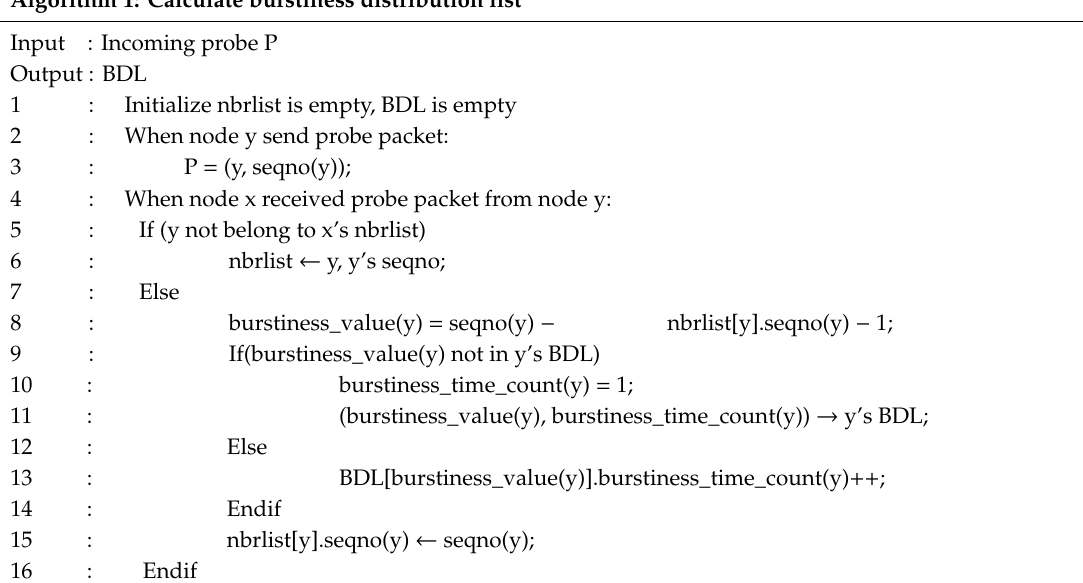
Algorithm 1: Calculate burstiness distribution